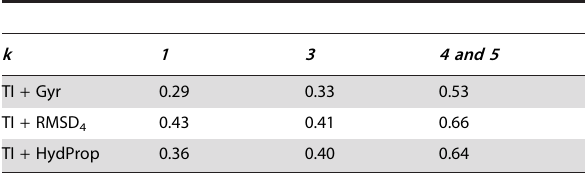
Table 3. CE for combinations of factors for various levels of k- nearest